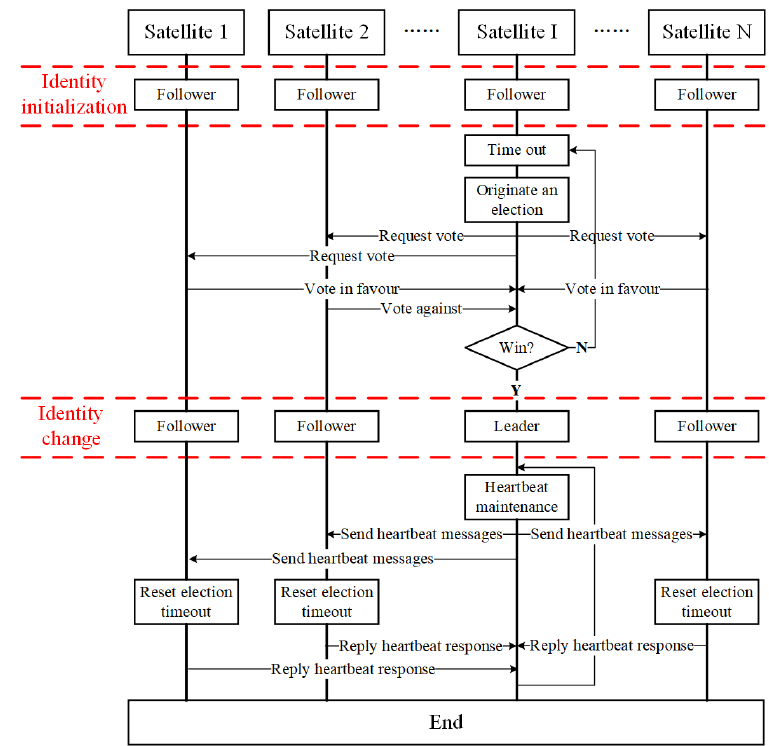
Figure 3. The leader election process of RAFT.